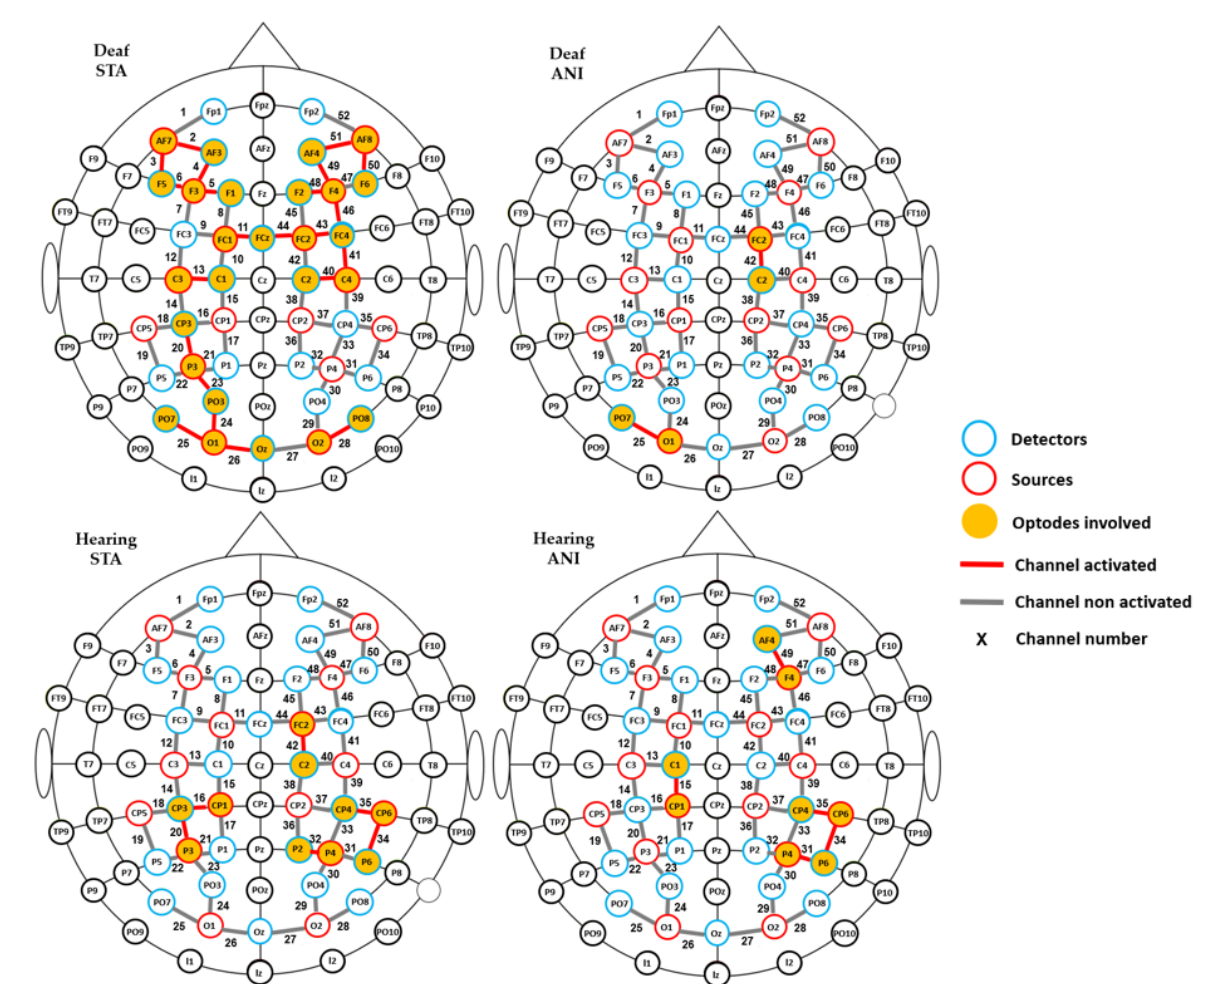
Figure 4. Channels with significantly positive activation for each group (deaf and hearing) and format (STA: sequence of static images; ANI: animated format).